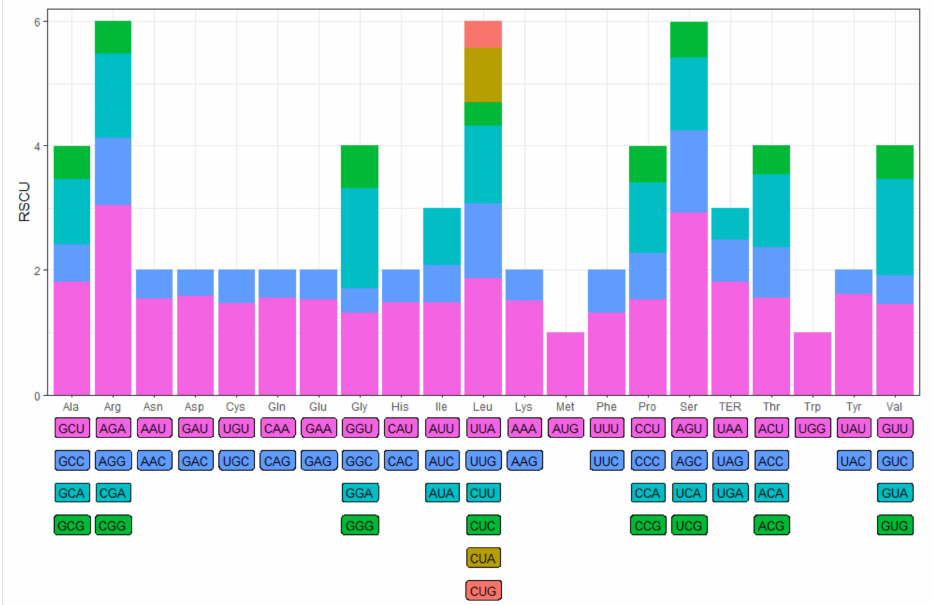
Figure 3. Relative synonymous codon usage (RSCU) of chloroplast genes in Mangifera